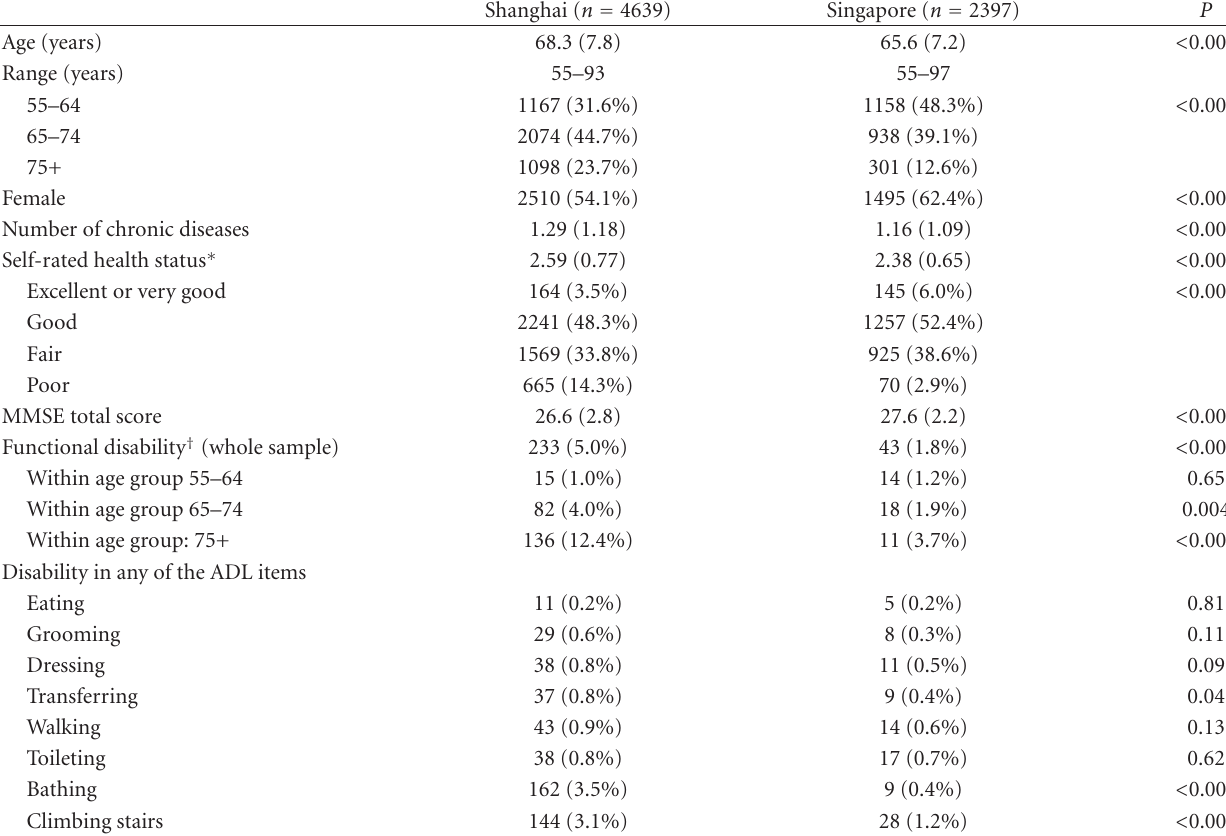
Table 1: Characteristics of the participants.